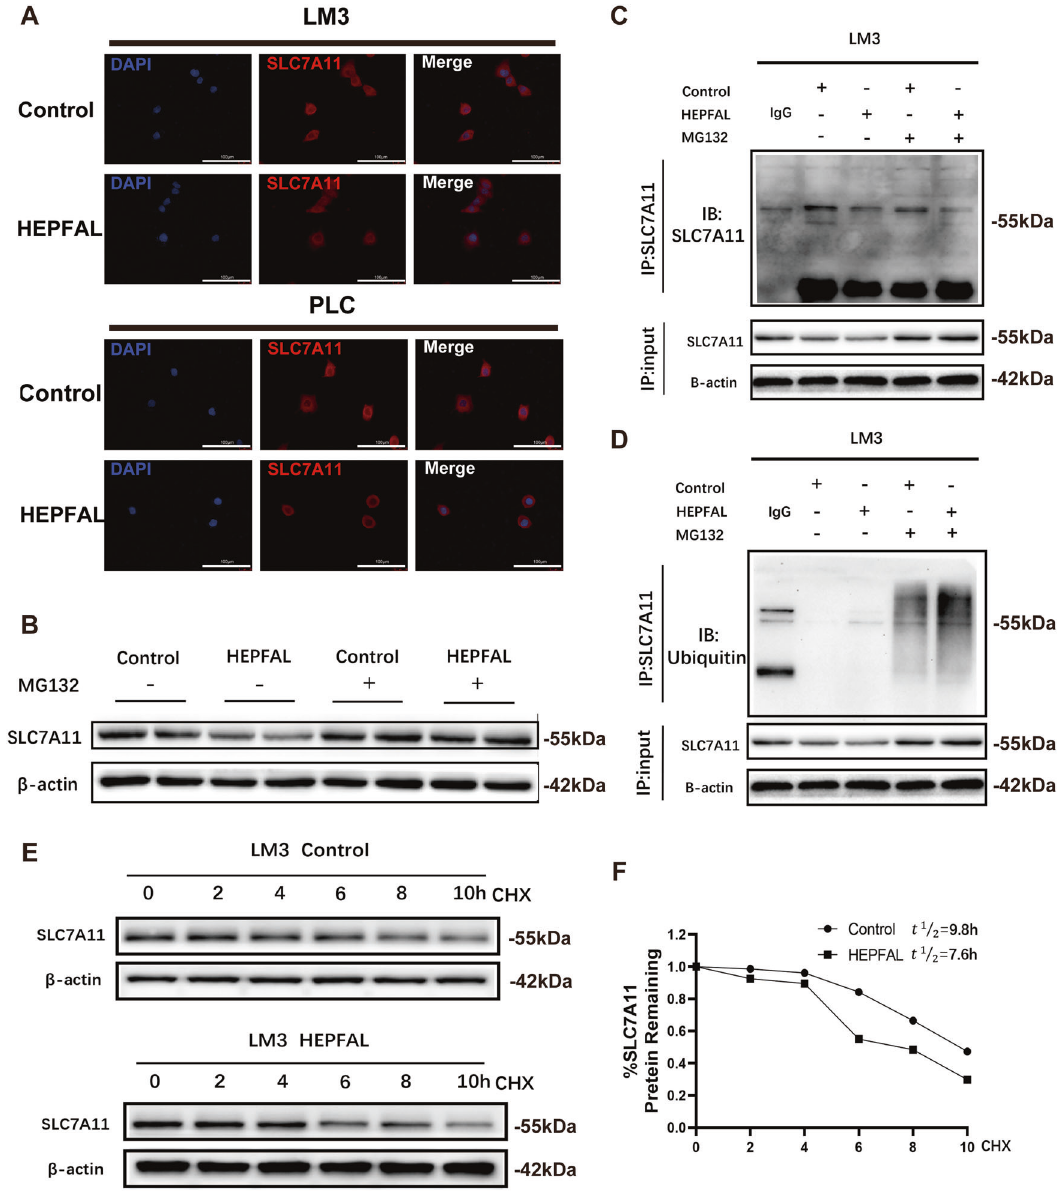
antibody, and the ubiquitination of SLC7A11 was examined by western blot. E , F HCCLM3 cells transfected with lncRNA HEPFAL expression vector or control vector were treated with 50 mg/ml CHX and detected the expression of SLC7A11 by western blot. The intensity of endogenous SLC7A11 expression for each time point was quanti fi ed by densitometry and drawn into a line